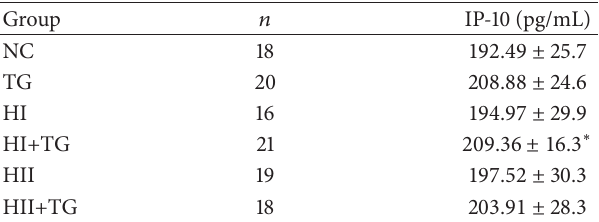
Table 4: Expression of IP-10 in rat serum (mean ± SD).